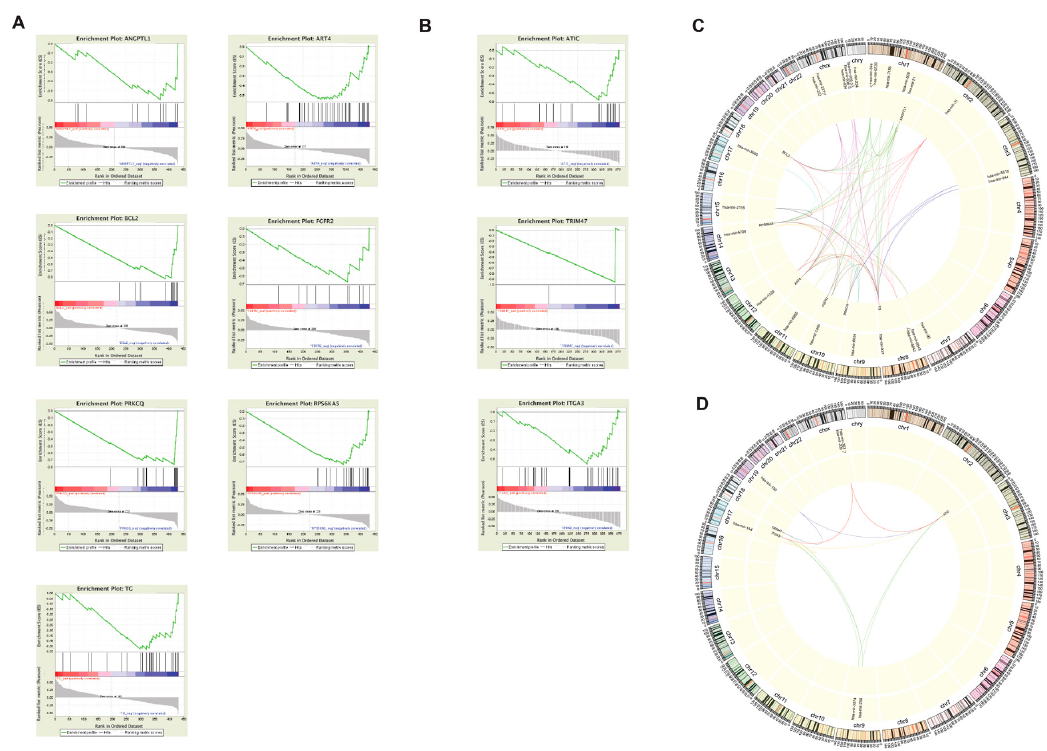
Figure 6. miRNA silencing of dysregulated CA / IA genes. GSEA analysis for ( A ) the CPTC vs normal comparison and ( B ) the FVPTC vs normal comparison. miRNA silencing is indicated by a downward-facing peak at the left extreme of the plot. ( C , D ) Circos plots for CPTC and FVPTC, respectively, visualize connections between multi-target miRNAs (more than one target) and the genes that they potentially